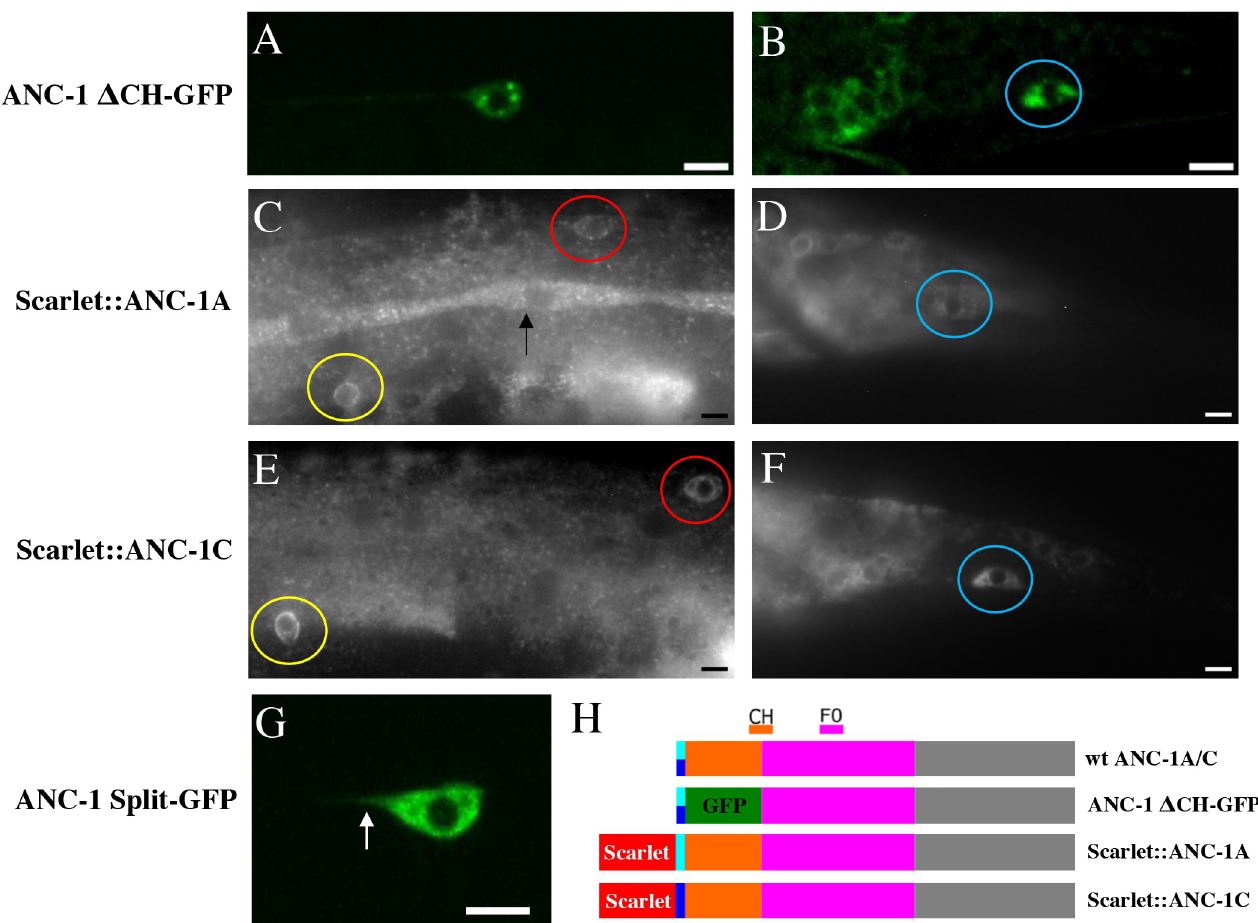
Fig 3. ANC-1A and ANC-1C are enriched in touch receptor neurons and are localized to the base of the proximal axon. (A) Expression of ANC- 1 Δ CH-GFP, a marker for ANC-1A and ANC-1C, in the ALM neuron. (B) Expression of ANC-1 Δ CH-GFP in the PLM neuron. Also see S1 Fig for colocalization with the Touch Receptor Neuron marker. (C) Expression of Scarlet::ANC-1A in the ALM (red circle) and AVM (yellow circle). Expression also seen in the seam cells (see arrow). (D) Expression of Scarlet::ANC-1A in the PLM (blue circle). (E) Expression of Scarlet::ANC-1C in the ALM (red circle) and the AVM (yellow circle). (F) Expression of Scarlet::ANC-1C in the PLM (blue circle). (G) ANC-1 visualized by split GFP. The ANC-1 protein was endogenously tagged with 2XGFP11 and GFP1-10 was expressed by a transgene ( Pmec-4 :: gfp1-10) . (H) Schematic of mutant forms of ANC-1. Anterior is to the left. Scales bars are 5 μ